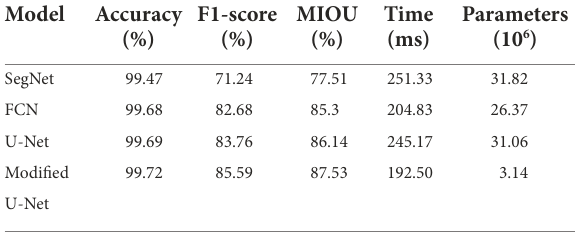
TABLE 2 Segmentation results of different